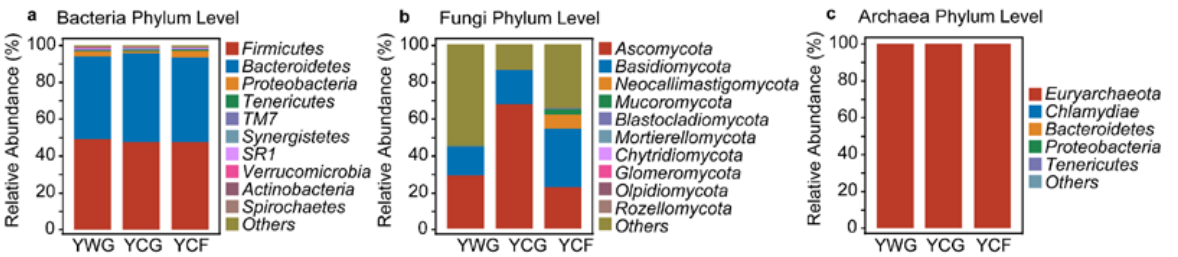
Figure 3. Phylum-level distribution of the rumen bacteria ( a ), fungi ( b ), and archaea ( c ) in three groups. Relative abundance of top 10 for rumen microbiota of yaks. YWG: Warm-season grazing, YCG: Cold-season grazing, YCF: Cold-season indoor feeding.